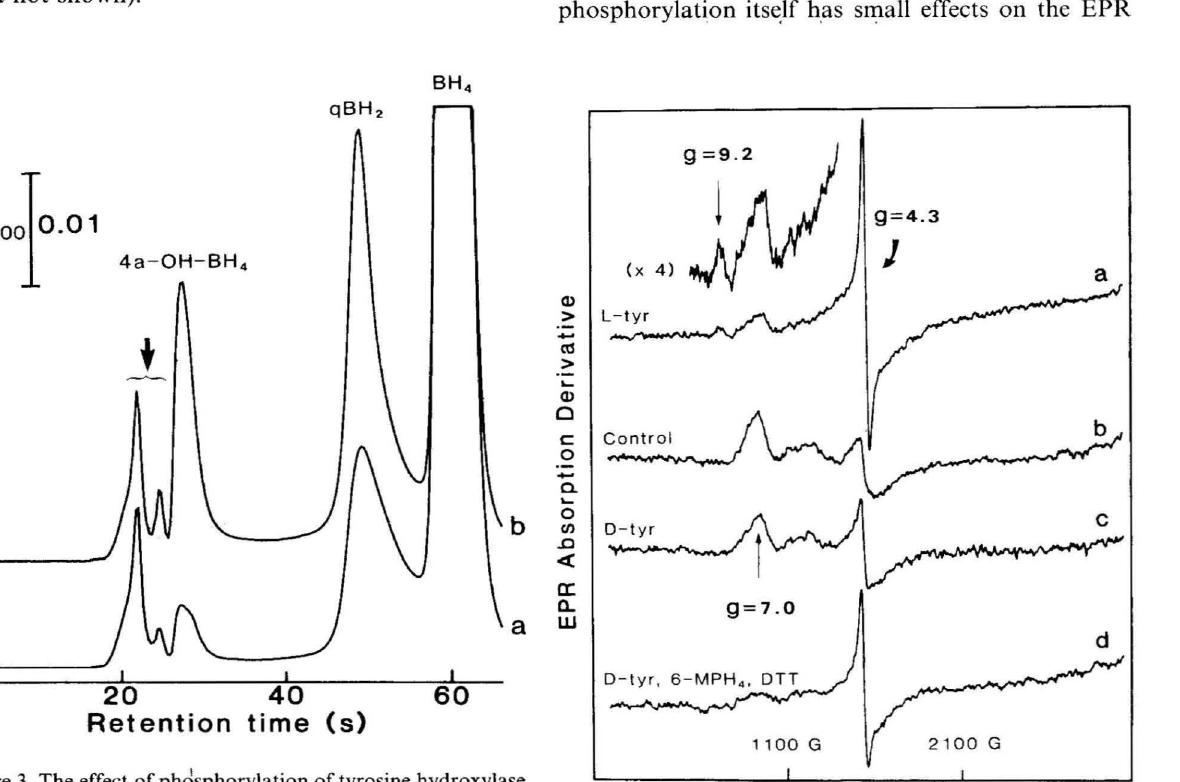
Figure 3. The effect of phdsphorylation of tyrosine hydroxylase on the formation of 4a-Ofl-BH. and qBH 2• Unphosphorylated (trace a) or phosphorylated (trace b, upper trace) tyrosine hy droxylase (2 giL) was incubated with 0.5 mmol/L BH. in the presence of 1 mmol/L DTT, 2 mmol/L L-phenylalanine, 0.2 giL catalase and toO mmol/L Tris-HCI, pH 8.4. After incubation for 2 min at 25 DC, a 20).l1 aliquot was injected into the liquid chromatograph, and the absorbance was measured at 300 nm. The vertical arrow indicates components of the incubation mixture (Tris and ATP) eluting at or shortly after the solvent front.